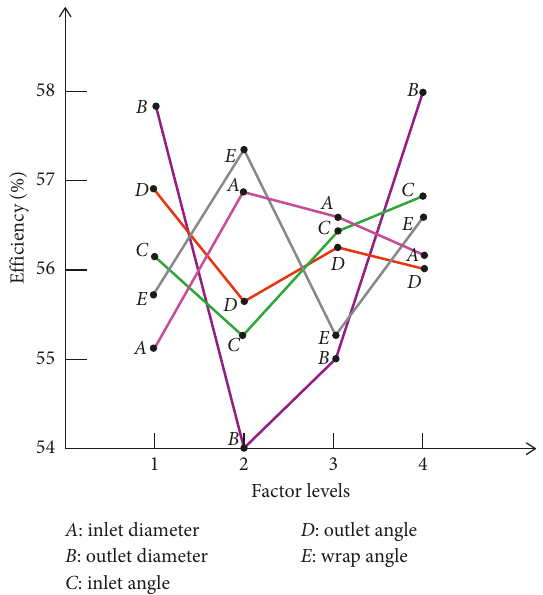
Figure 8: Influence trend of each parameter on efficiency. Table 5: Influence data of various factors on cavitation.